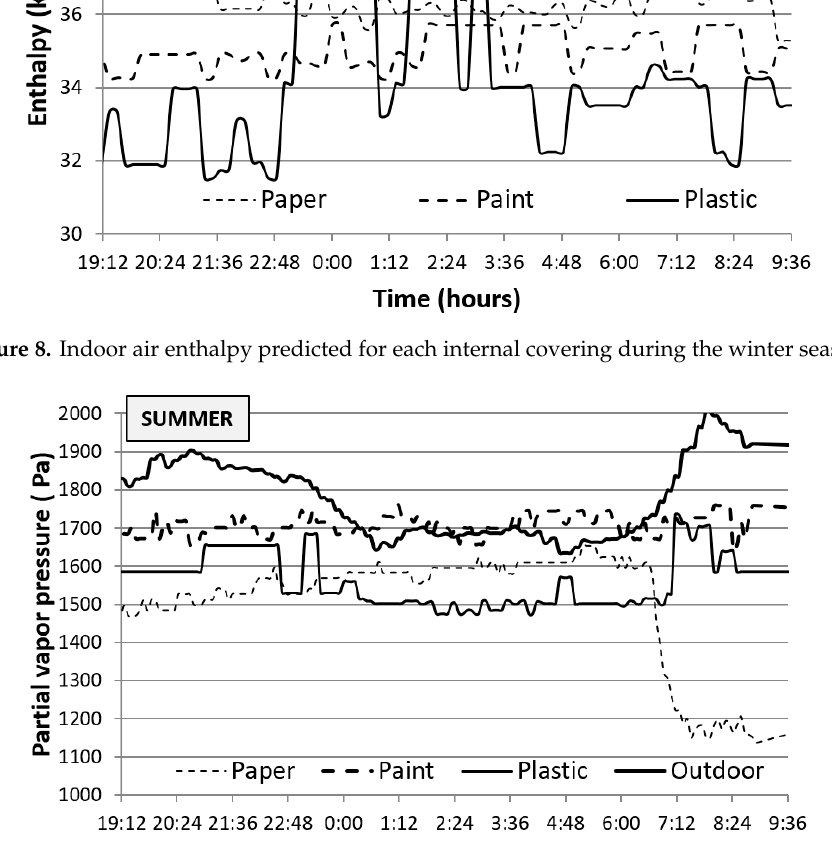
Figure 9. Indoor air partial vapor pressure predicted for each internal covering during the summer season.